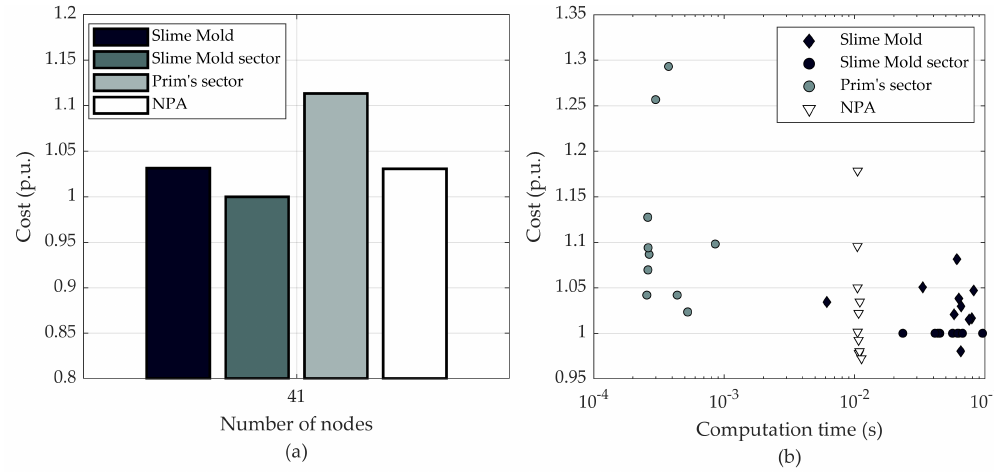
Figure 7. Average cost of intermediate networks ( a ), and the cost and the computation time of each network ( b